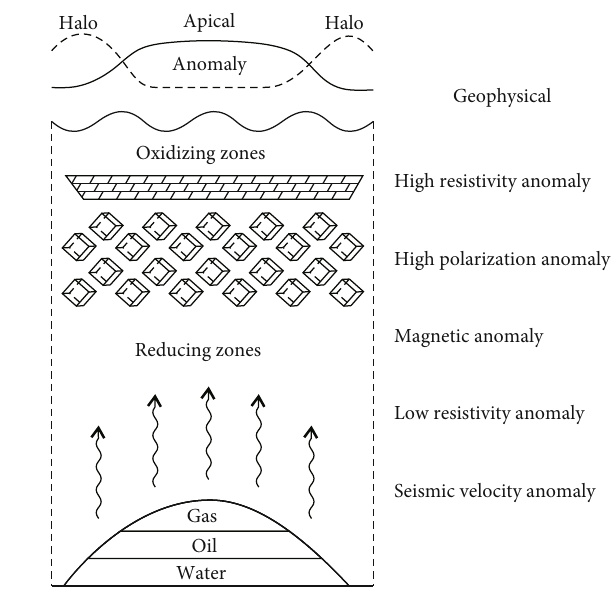
Figure 2: Hydrocarbon micropermeability model and the e ff ect of hydrocarbons on soil and sediment